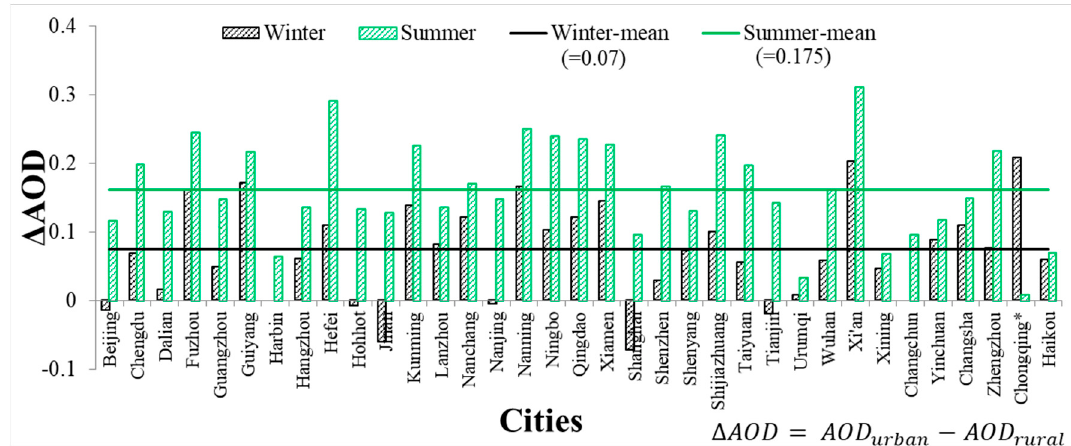
Figure 4. The spatial differences in aerosol optical depth (AOD) ( ∆ AOD = AOD urban − AOD rural ) between the urban and rural areas in and around the 35 cities based on MODIS AOD. Black and green bars represent ∆ AOD in winter and summer, respectively. The overall mean ∆ AOD calculated using data in winter and summer are shown as black and green lines, respectively. The city marked with an asterisk (Chongqing) shows results opposite to those of the other cities.